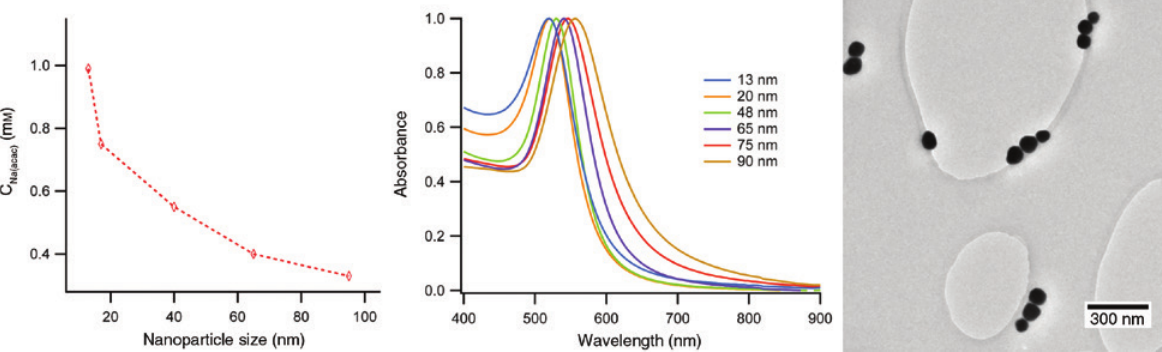
Figure 2: Left: Nanoparticle size evolution depending on the acetylacetonate concentration. Right: UV/Vis (middle) and TEM analysis